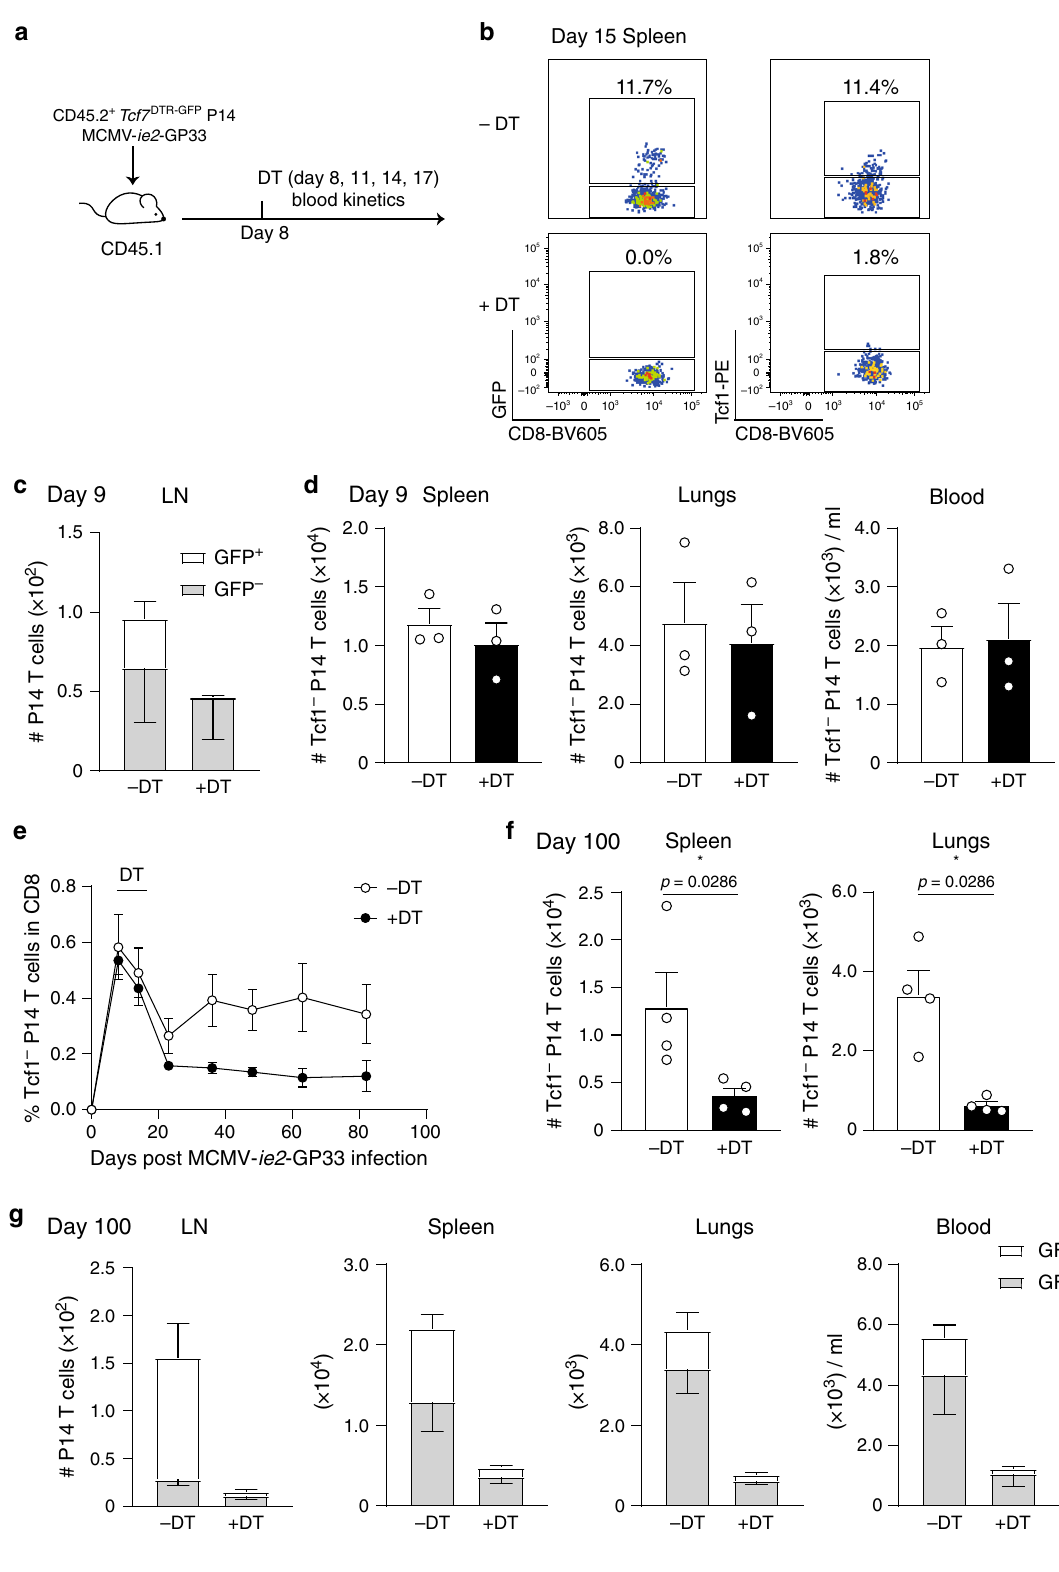
tissues (Supplementary Fig. 5d, e). Unique clonotypes isolated from the blood, representing the total T cell repertoire, gave the expected gaussian distribution for the CDR3 length selection (Supplementary Fig. 5f) 40 . These results show that the M38- speci fi c Tcf1 + pool has a larger clonal diversity than the Tcf1 −